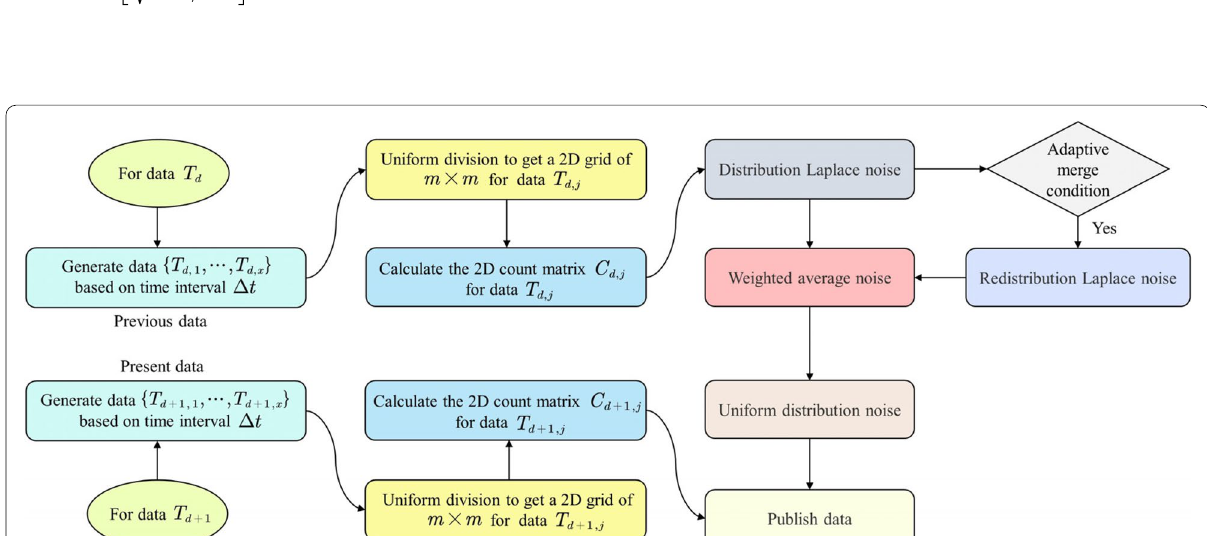
Fig. 3 Differential privacy data publishing process in the AG